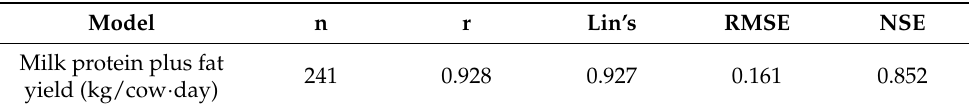
Figure 2. Production surface curves for the two-variable quadratic relationship between concentrate and pasture + forage intake and predicted milk protein plus fat yield (kg/cow · day) for the ( a ) spring and ( b ) autumn scenarios. Table 7. Measures of fit for the model determined for milk protein plus fat yield (kg/cow · day). The comparison is made between yields measured experimentally and yields predicted employing the fitted model fixed effects. n = number of treatment means contributing to model, r = correlation coefficient, Lin’s = Lin’s concordance coefficient, RMSE = Root Mean Square Error of difference and NSE = Nash–Sutcliffe coefficient of efficiency.